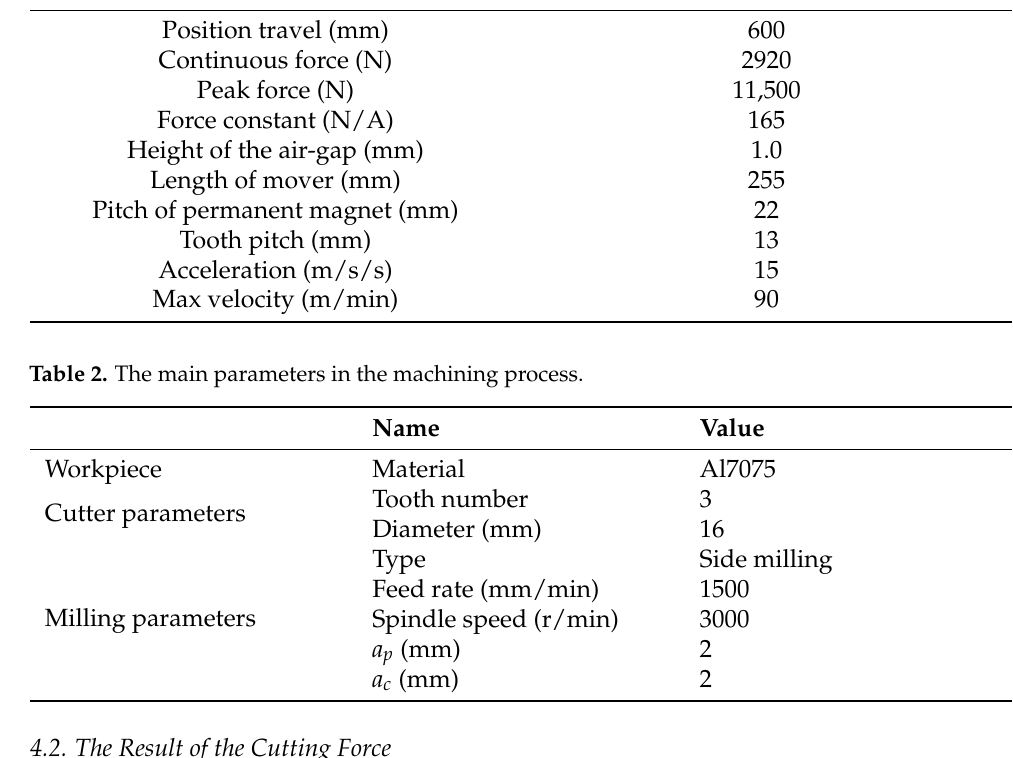
Table 2. The main parameters in the machining process.